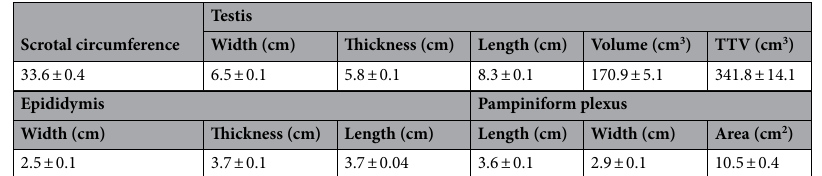
Table 1. Measurements (mean ± SEM) of testis, epididymis, and pampiniform plexus with B-Mode ultrasonography.